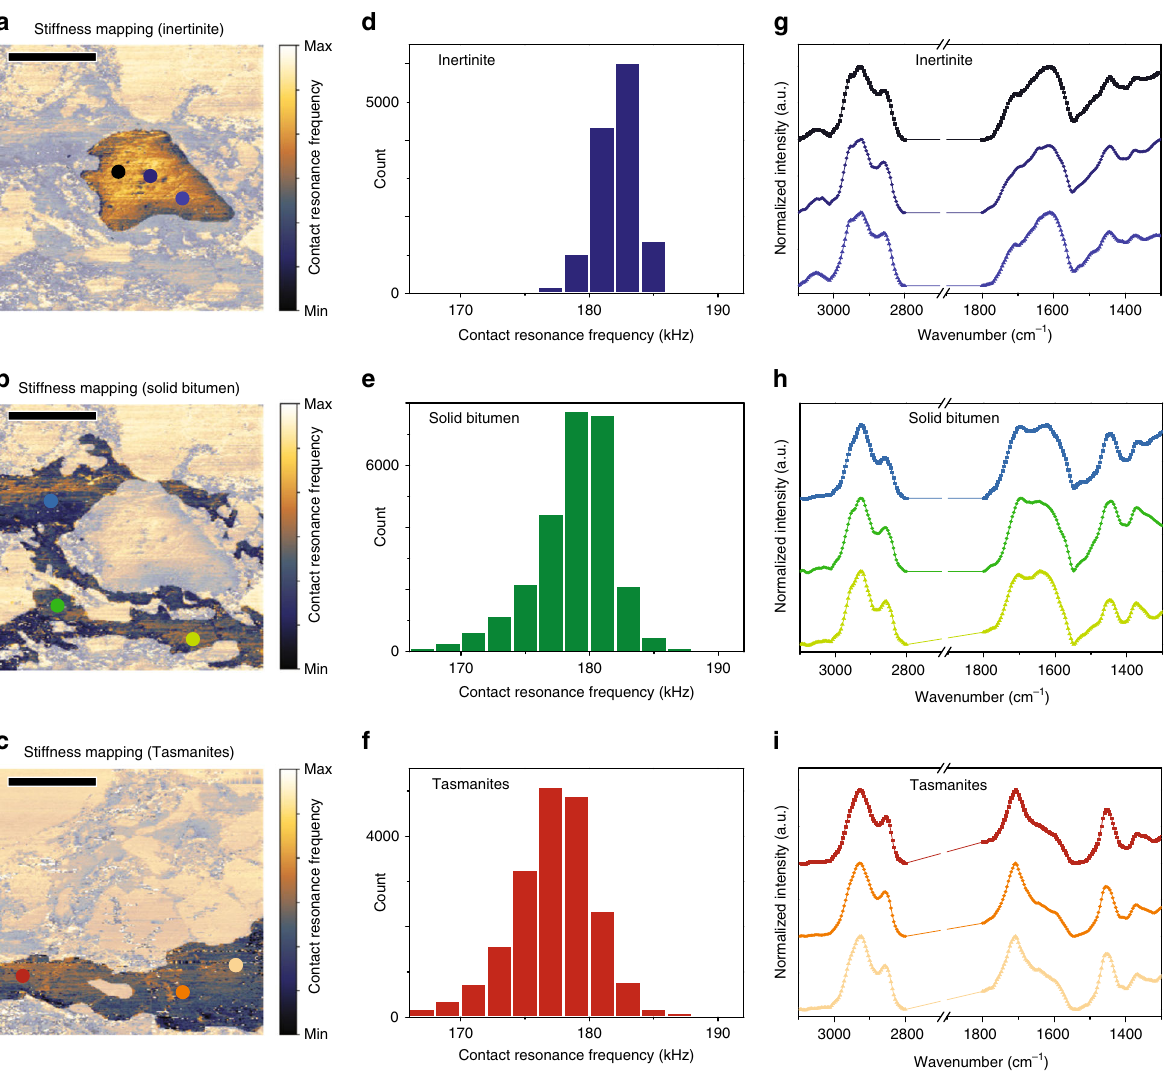
Fig. 3 Nanoscale geochemical and geomechanical characterization. Inertinite ( a ), solid bitumen ( b ), and Tasmanites ( c ) in stiffness images are identi fi ed by comparison with photomicrograph of the same fi eld (Figs. 1a and 2a). Areas outside of regions of interest are masked with opaque color to screen out irrelevant contact resonance (CR) frequency measurements. CR frequency histogram for 130.74 μ m 2 area of inertinite ( d ), 272.97 μ m 2 area of solid bitumen ( e ), and 201.67 μ m 2 area of Tasmanites ( f ). Localized IR spectra from different locations (colored points in corresponding stiffness images) in inertinite ( g ), solid bitumen ( h ), and Tasmanites ( i )